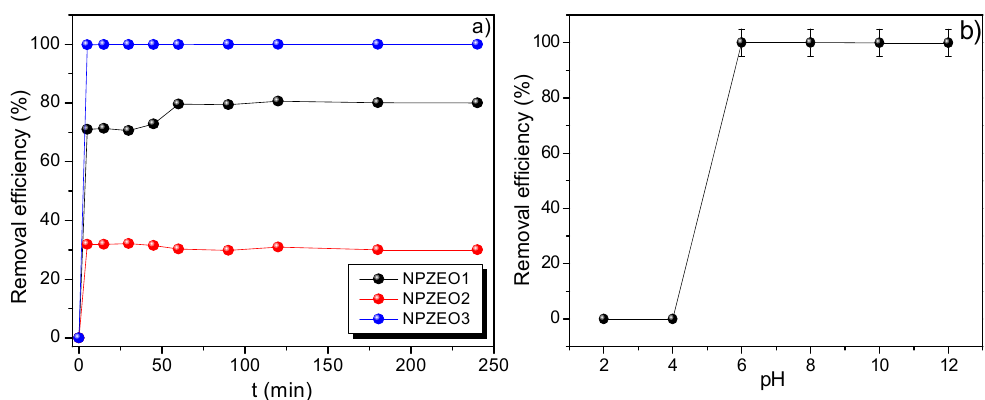
Figure 6. Pb(II) adsorption kinetic curves obtained for NPZEO1, NPZEO2, and NPZEO3 samples ( a ). pH dependence of the removal efficiency for sample NPZEO3 ( b ).